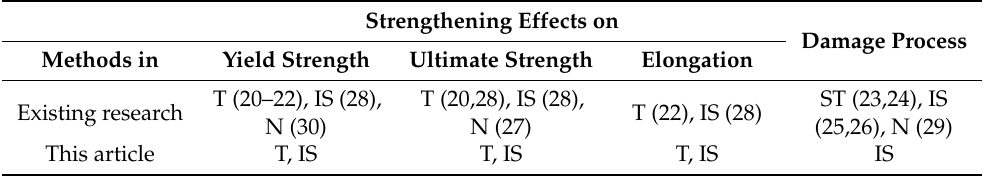
Table 1. Research methods of strengthening and damage process in particles reinforced metal matrix composites